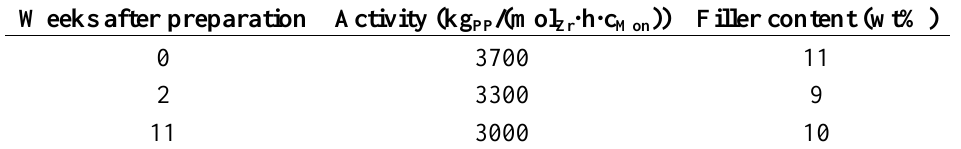
Table 4. Stability of MAO impregnated nano silica balls in syndiotactic propene